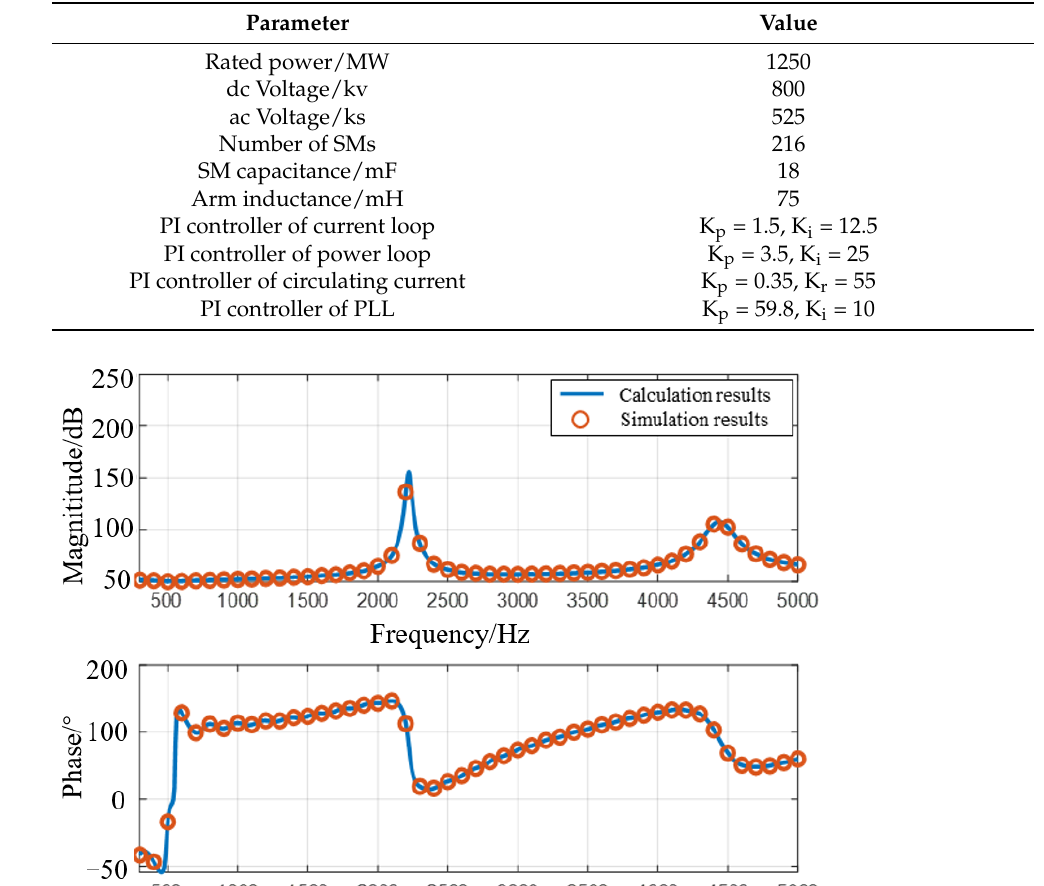
Table 1. Parameters of MMC.